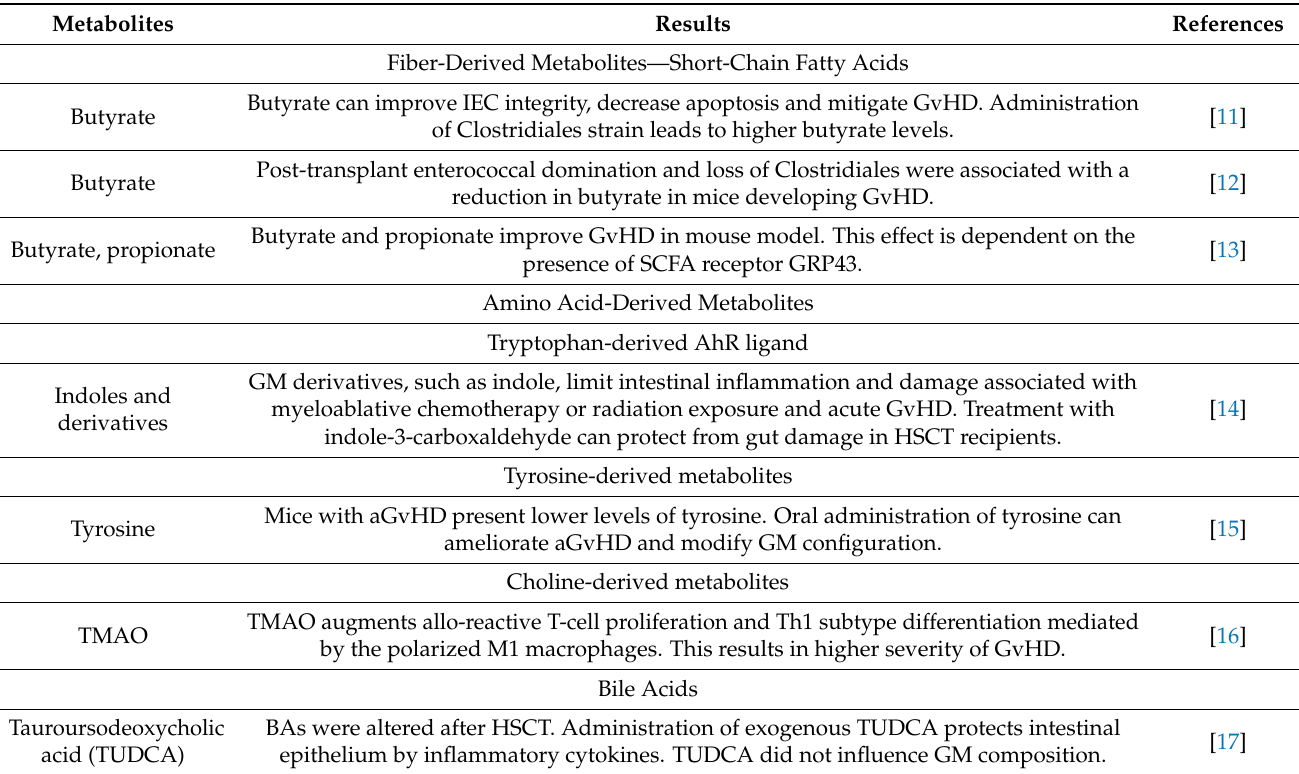
Table 1. Summary of studies investigating the role of microbiome-derived metabolites in HSCT setting in mouse model. Metabolites